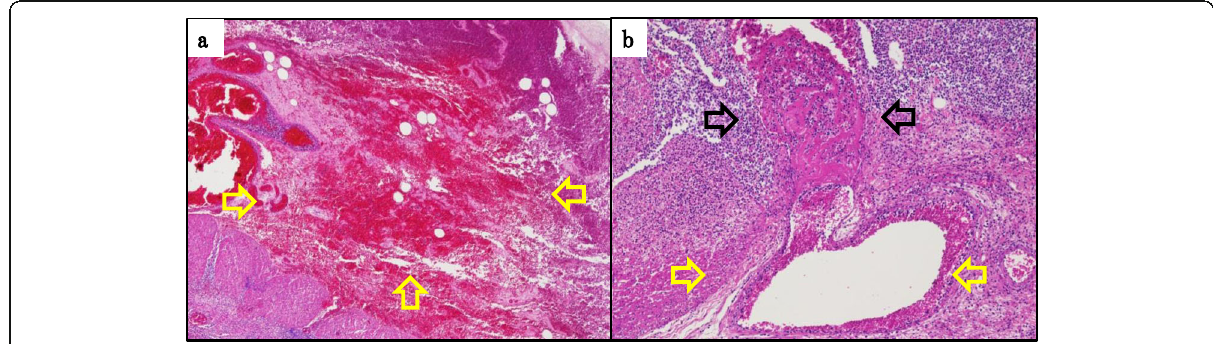
Fig. 3 Pathological findings. a Diffuse edema and necrotic changes were found at the mucosal, submucosal, and muscle layers and part of the subserosa (yellow arrow). b In some dilated mesentery veins, there was gas embolus (yellow arrow), and thrombus formation was found near the peripheral side (black